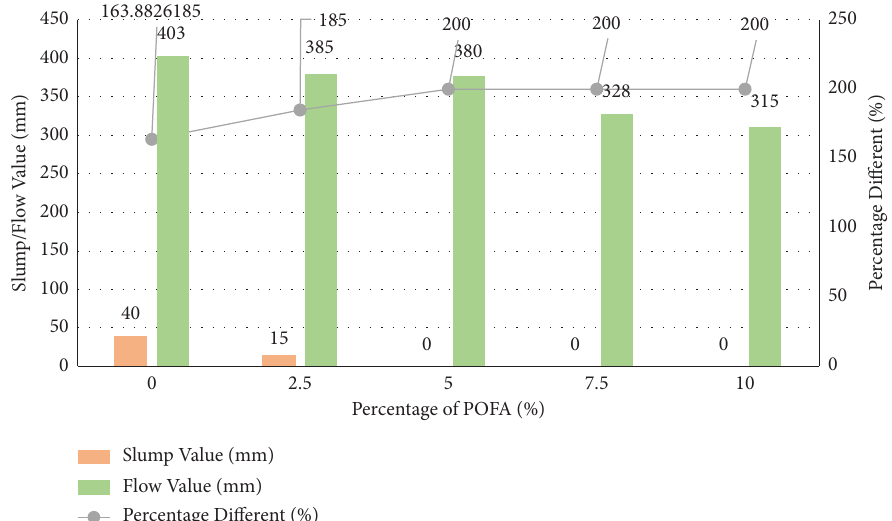
Figure 8: Relationship between the slump value and fow value of